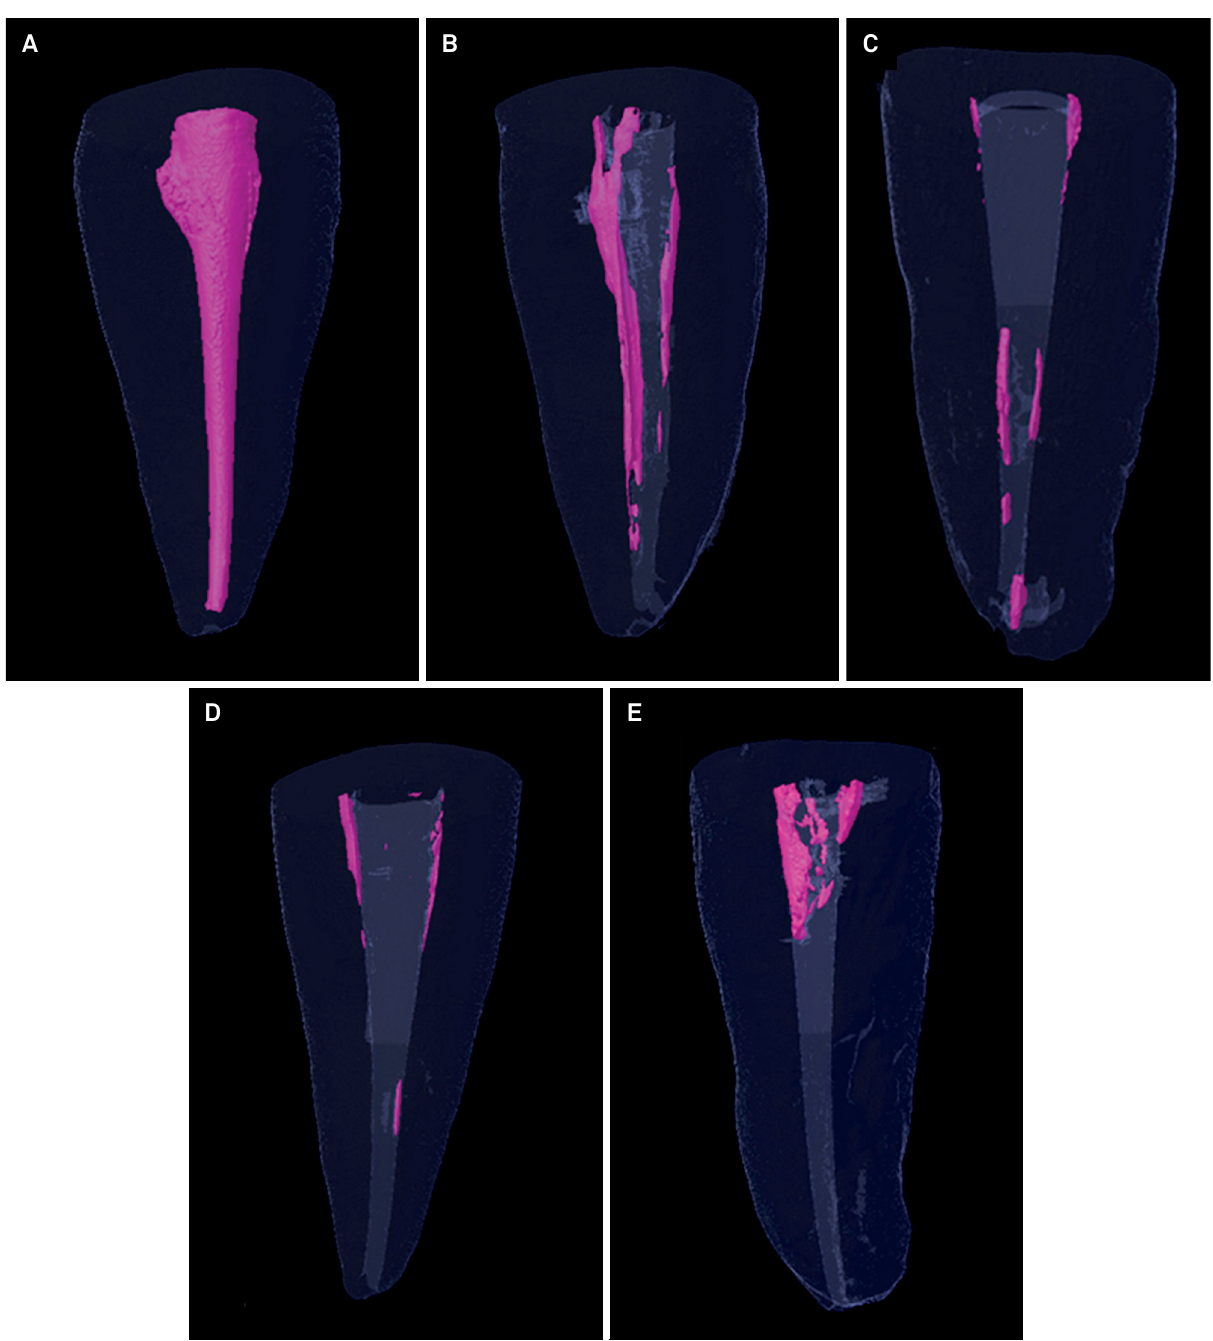
Figure 1. μCT scans of the positive control group and experimental groups. A (positive control): Filled root canal. B (PTR): presence of filling material remnants in the middle and coronal thirds. C (PTR/xylol): presence of filling material remnants in the three canal thirds. D (PTR/orange oil): presence of filling material remnants in the middle and coronal thirds. E (PTR/eucalyptol): presence of filling material remnants only in the coronal